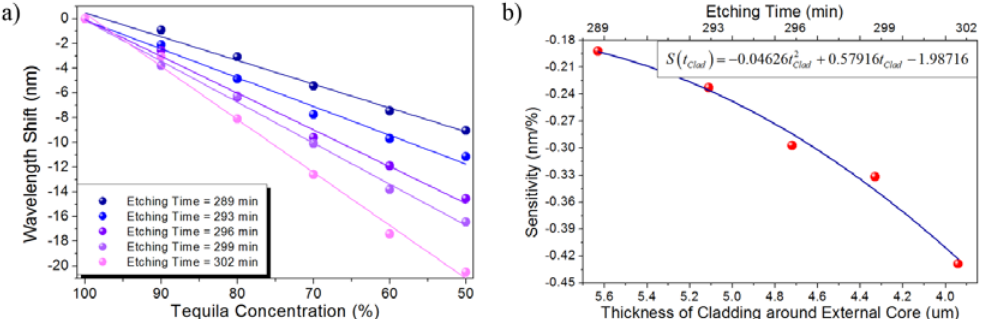
Figure 10. Diluted solutions of tequila: ( a ) Absolute wavelength shift of the sensor response; ( b ) Sensitivity of the TCF